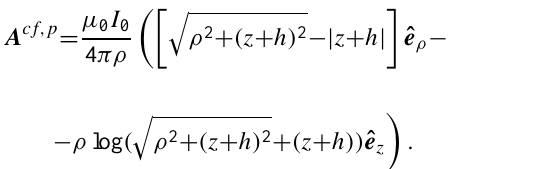
Fig. 13. Same as Fig. 11, but for the WTS model.